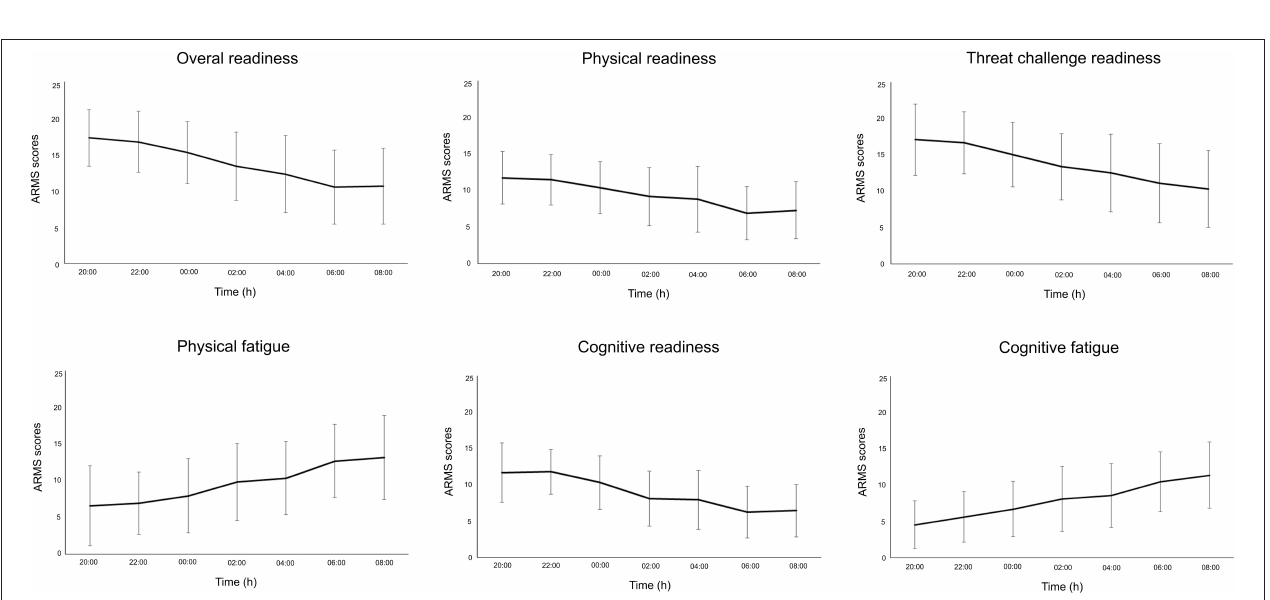
FIGURE 3 | Mean and standard deviation for each subscale of the Acute Readiness Monitoring Scale (ARMS) during the overnight assessments (from 20:00 to 08:00h).